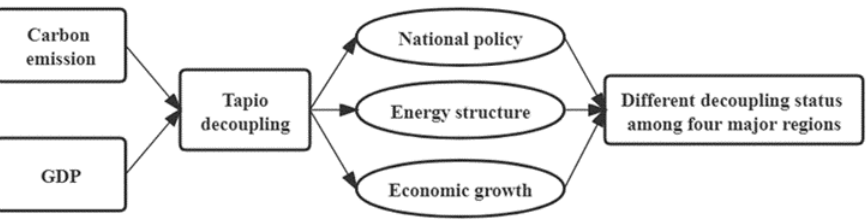
Figure 1. Conceptual framework.